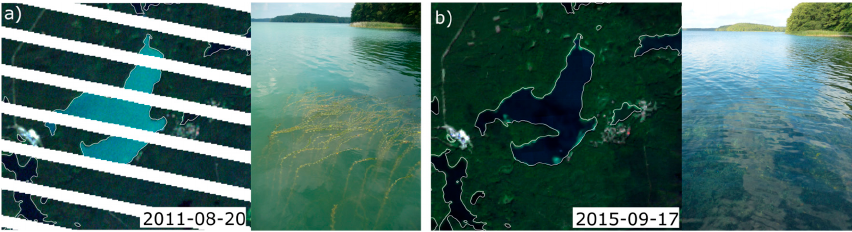
Figure 8. Two quasi-true color Landsat RGB of Stechlinsee with photos showing the water surface taken from a boat: ( a ) August 2011, showing the lake with calcite precipitation; and ( b ) September 2015, with clear water. The photos were taken: ( a ) two days before; and ( b ) nine days after the Landsat acquisition.